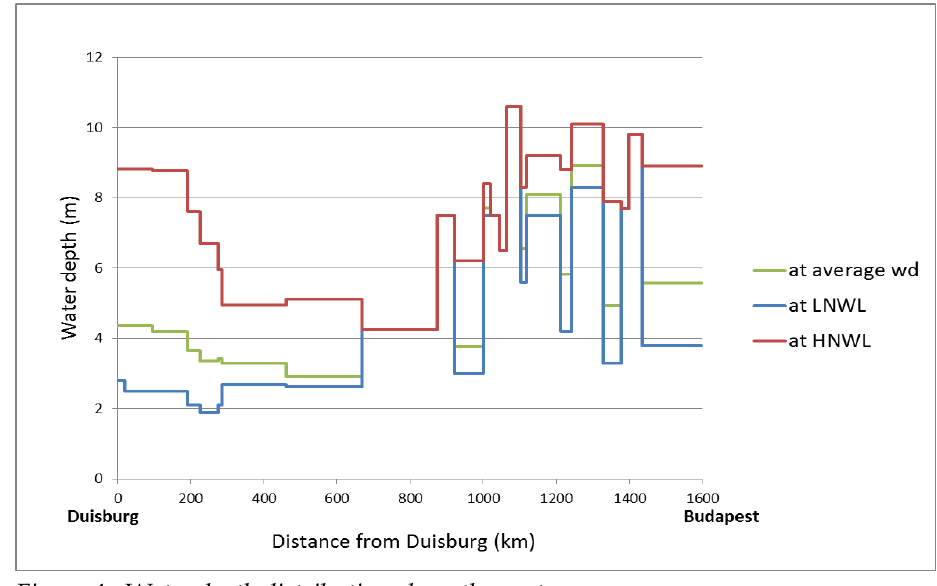
Figure 4. Water depth distribution along the route